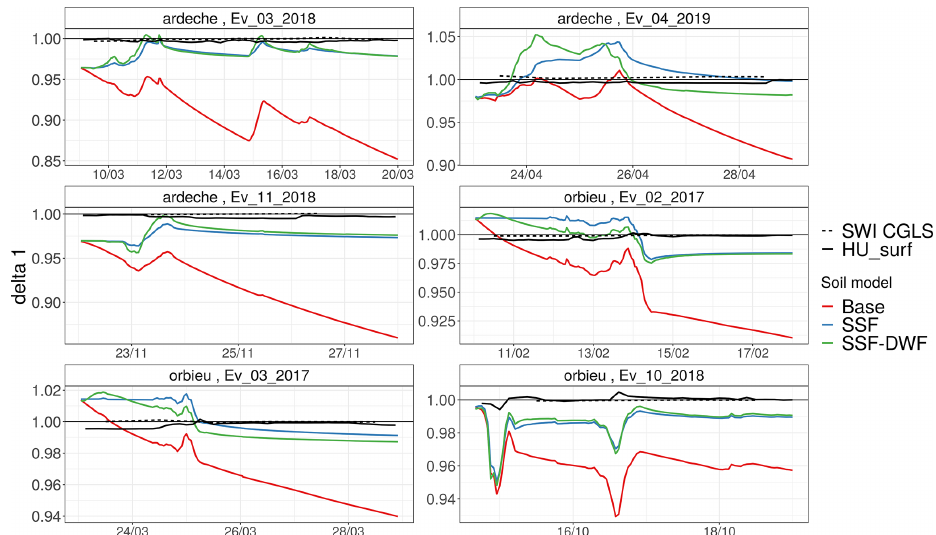
Figure 8. Time series of index δ 1 defined by Zoccatelli et al. (2011) for the six events, computed for the SSD outputs for the BM, SSF, and SSF–DWF models, and also for the LDAS-Monde HU surf variable and the CGLS SWI.